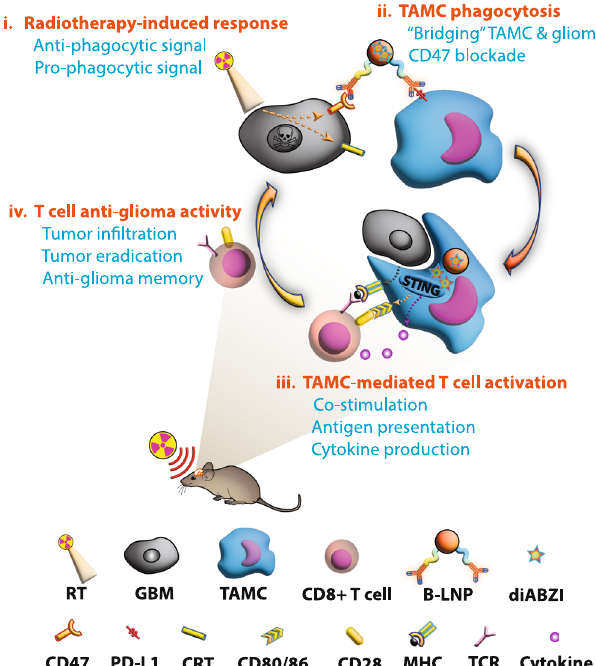
Fig. 1 | Schematic representation of B-LNP-mediated therapeutic hijacking of TAMCs to boost antitumor immunity and potentiate radiotherapy for GBM. i , Radiotherapy (RT) induces overexpression of pro-phagocytic signal calreticulin (CRT) and anti-phagocytic molecule CD47 in glioma cells. ii , B-LNPs were engi- neered to “ bridge ” TAMCs and GBM through CD47 and PD-L1 dual-ligation, block both checkpoint molecules, and promote phagocytosis of tumor cells. iii , In addition to acting as an engager, B-LNPs also encapsulate STING agonist to pro- motetypeIinterferonresponsesinTAMCs,whichtriggerin fi ltrationandactivation of tumor-antigen speci fi c T cells. iv , Reprogrammed TAMCs promote T cell- mediated antitumor responses, leading to durable tumor eradication. TCR, T cell receptor; MHC, major histocompatibility complex.The fi gurewasgenerated